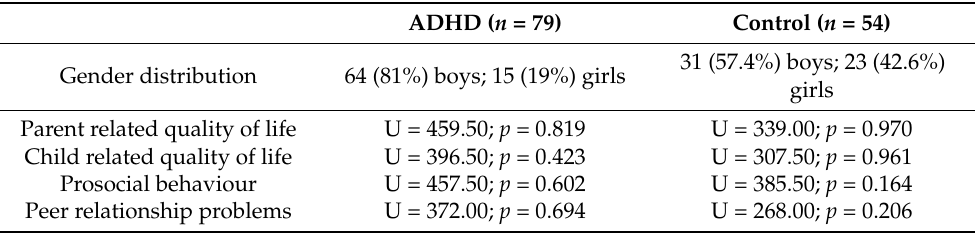
Table 1. Gender differences in parent-and child related quality of life, prosocial behaviour and peer relationship problems in the Attention-Deficit/Hyperactivity Disorder (ADHD) and control group. ADHD ( n = 79) Control ( n = 54) Gender distribution